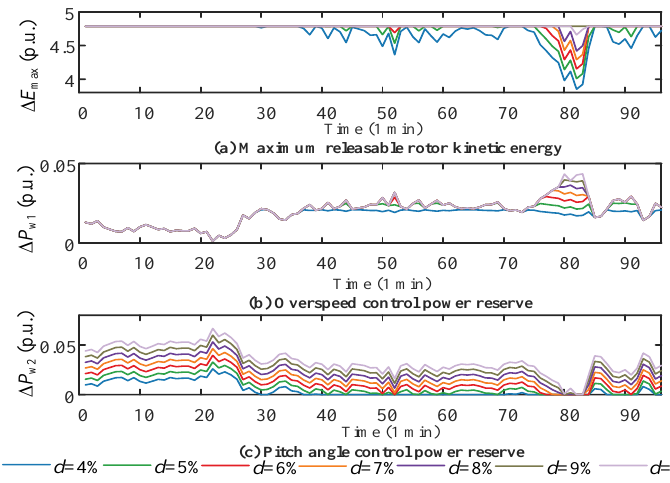
Figure 9. Wind power frequency regulation potential at different deloading